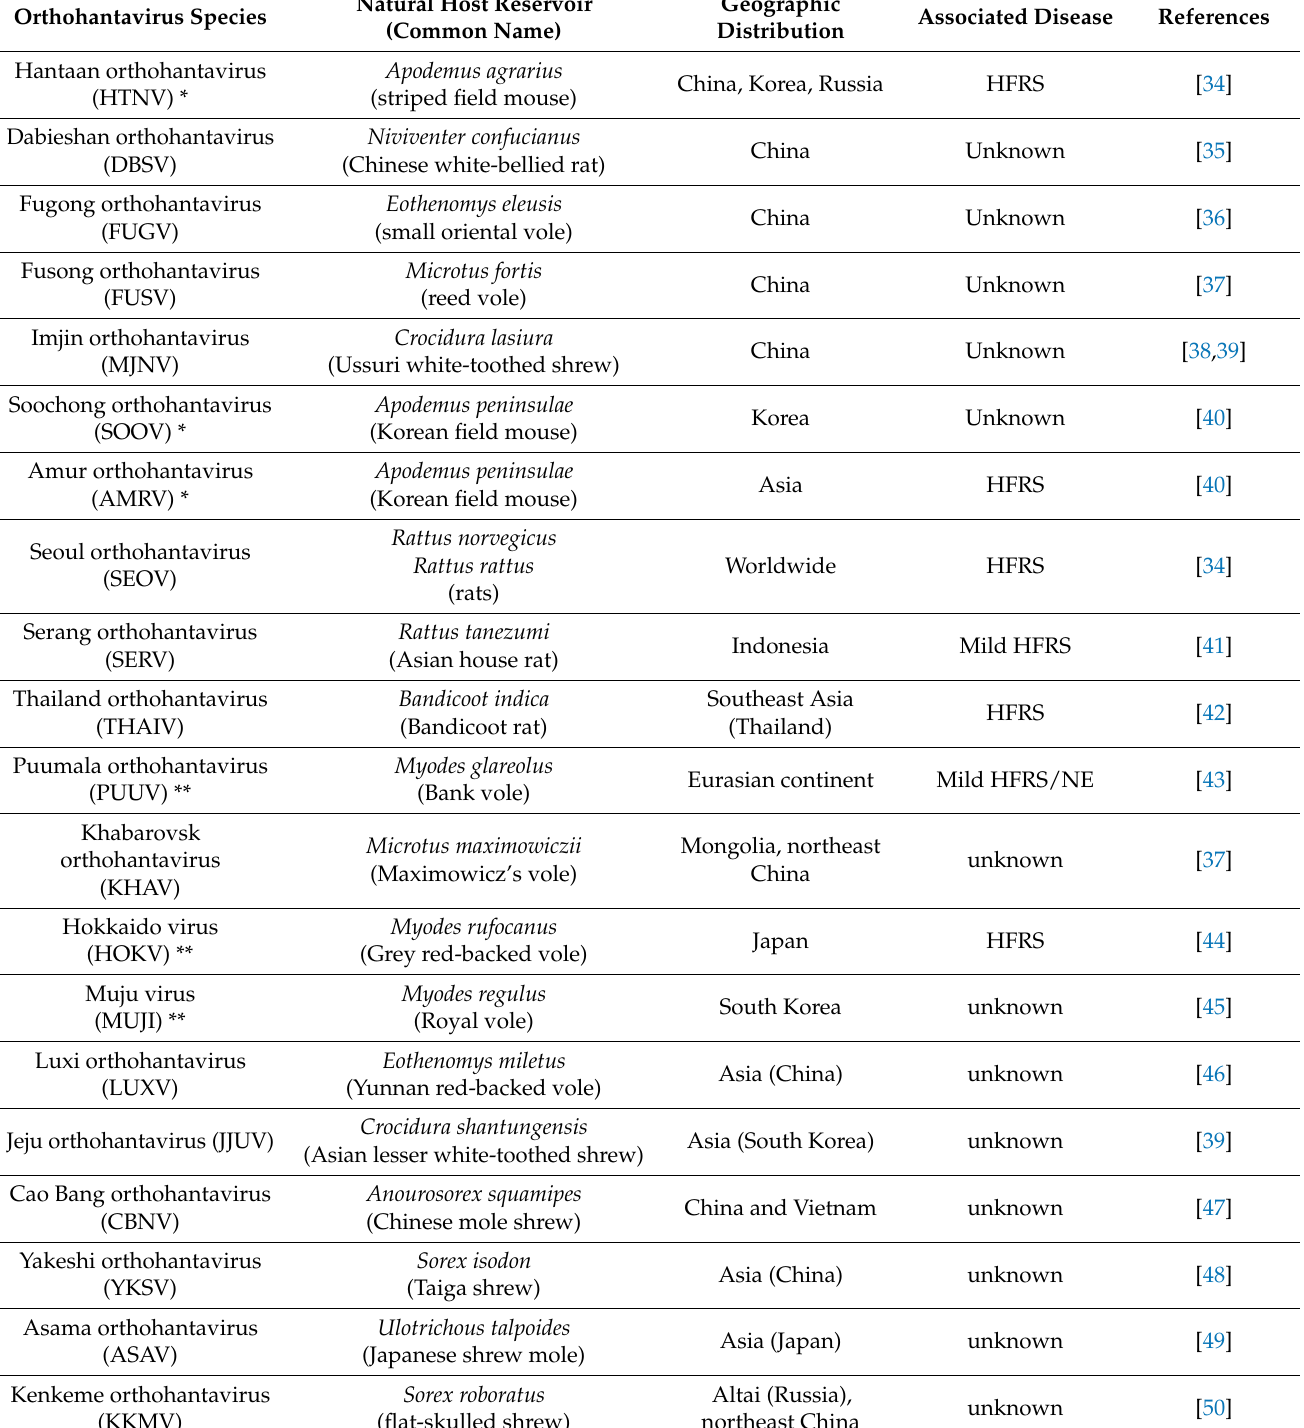
Table 1. Geographic distribution of orthohantaviruses and their host